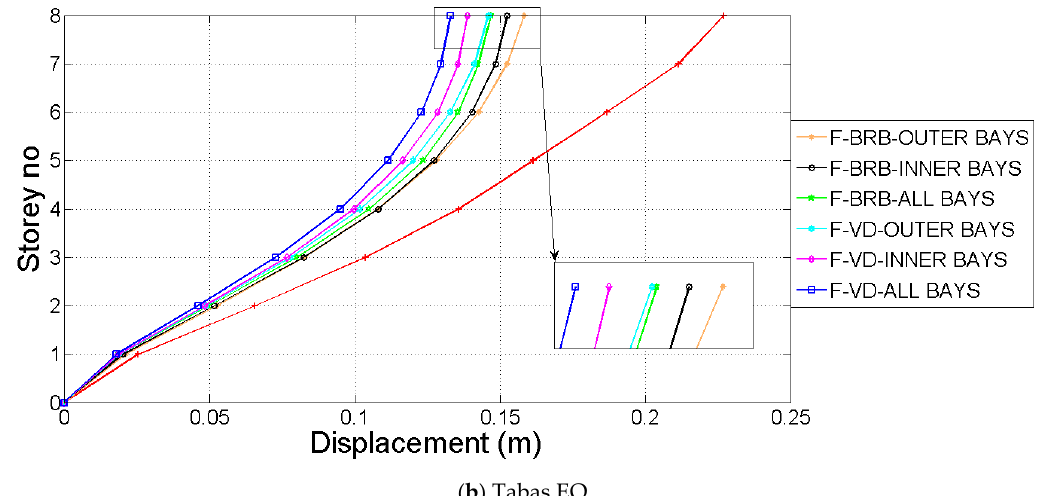
Figure 8. Variation of displacement with story level in 8-story frames.